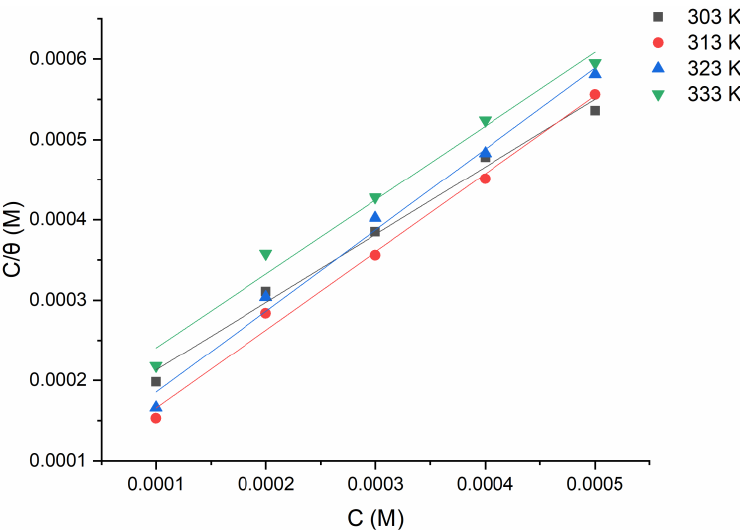
Figure 6. Langmuir adsorption model of tested inhibitor on the surface of mild steel in 1 M HCl at 303 K from the gravimetric data.